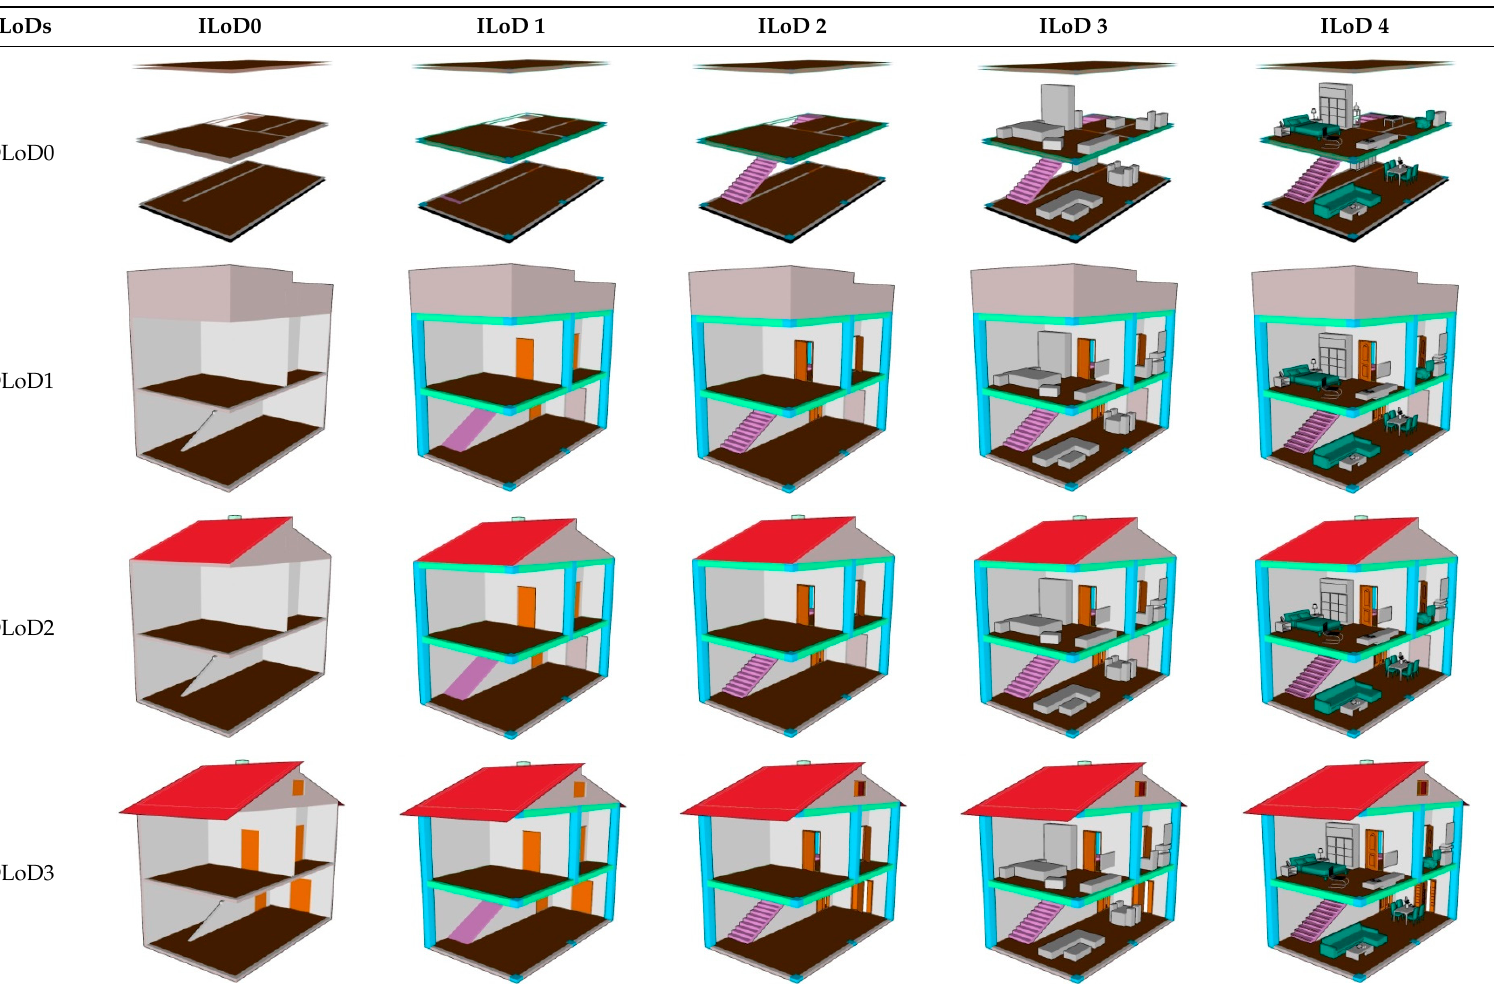
Table 1. Geometrical representations for building models in different full LoDs (FLoDs).